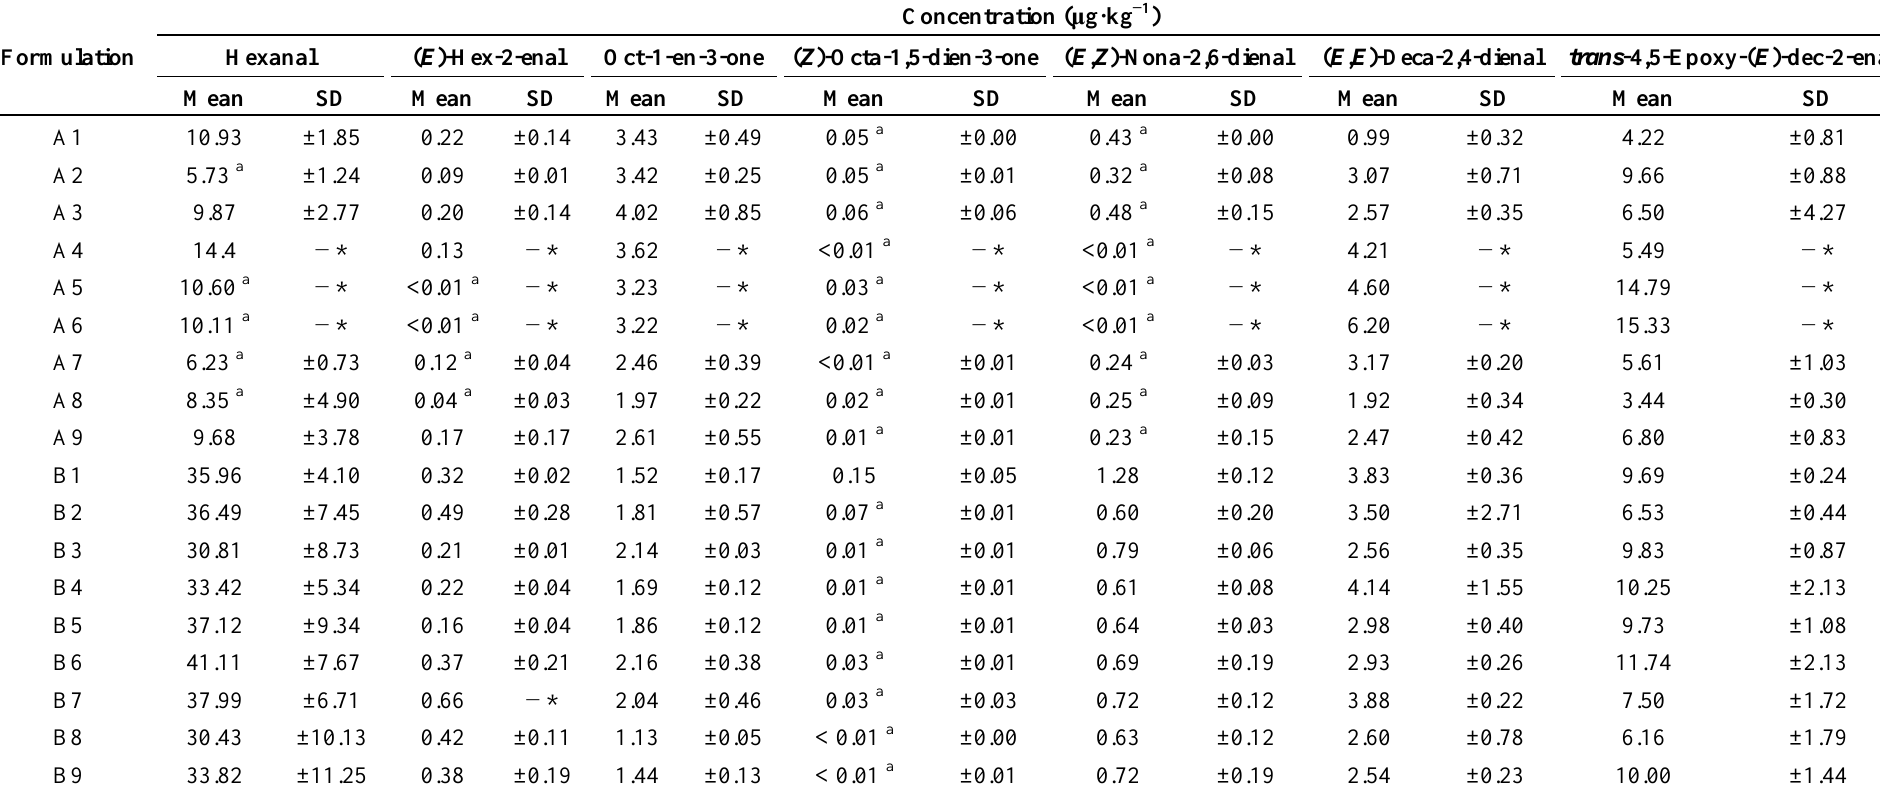
Table 3. Quantification of selected odorants in infant formulations directly after production (with and without antioxidants).